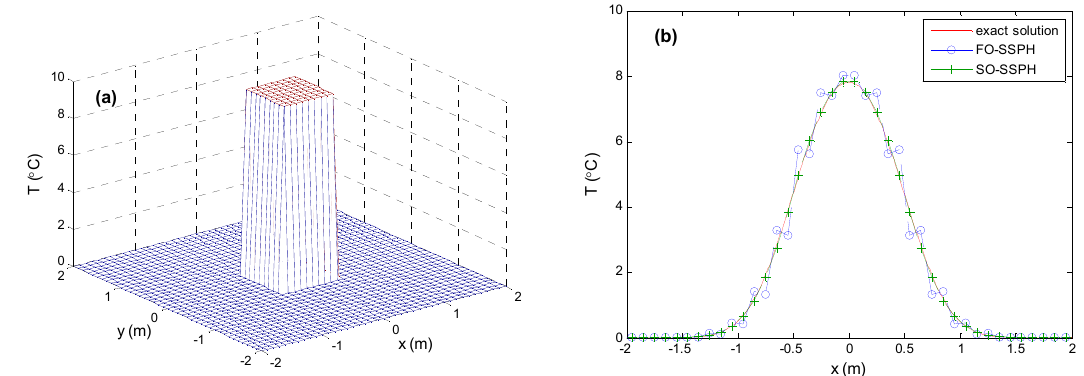
Figure 3. Two-dimensional heat conduction with discontinuous temperature distribution: ( a ) initial condition and ( b ) results of FO-SSPH and SO-SSPH along y = 0.05 m compared with exact solution. FO-SSPH and SO-SSPH are used to simulate this problem and the results at cross-section y = 0.05 m are shown in Figure 3b together with the exact solution. It is seen that for two-dimensional unphysical oscillations as might be expected, but the proposed SO-SSPH does not.